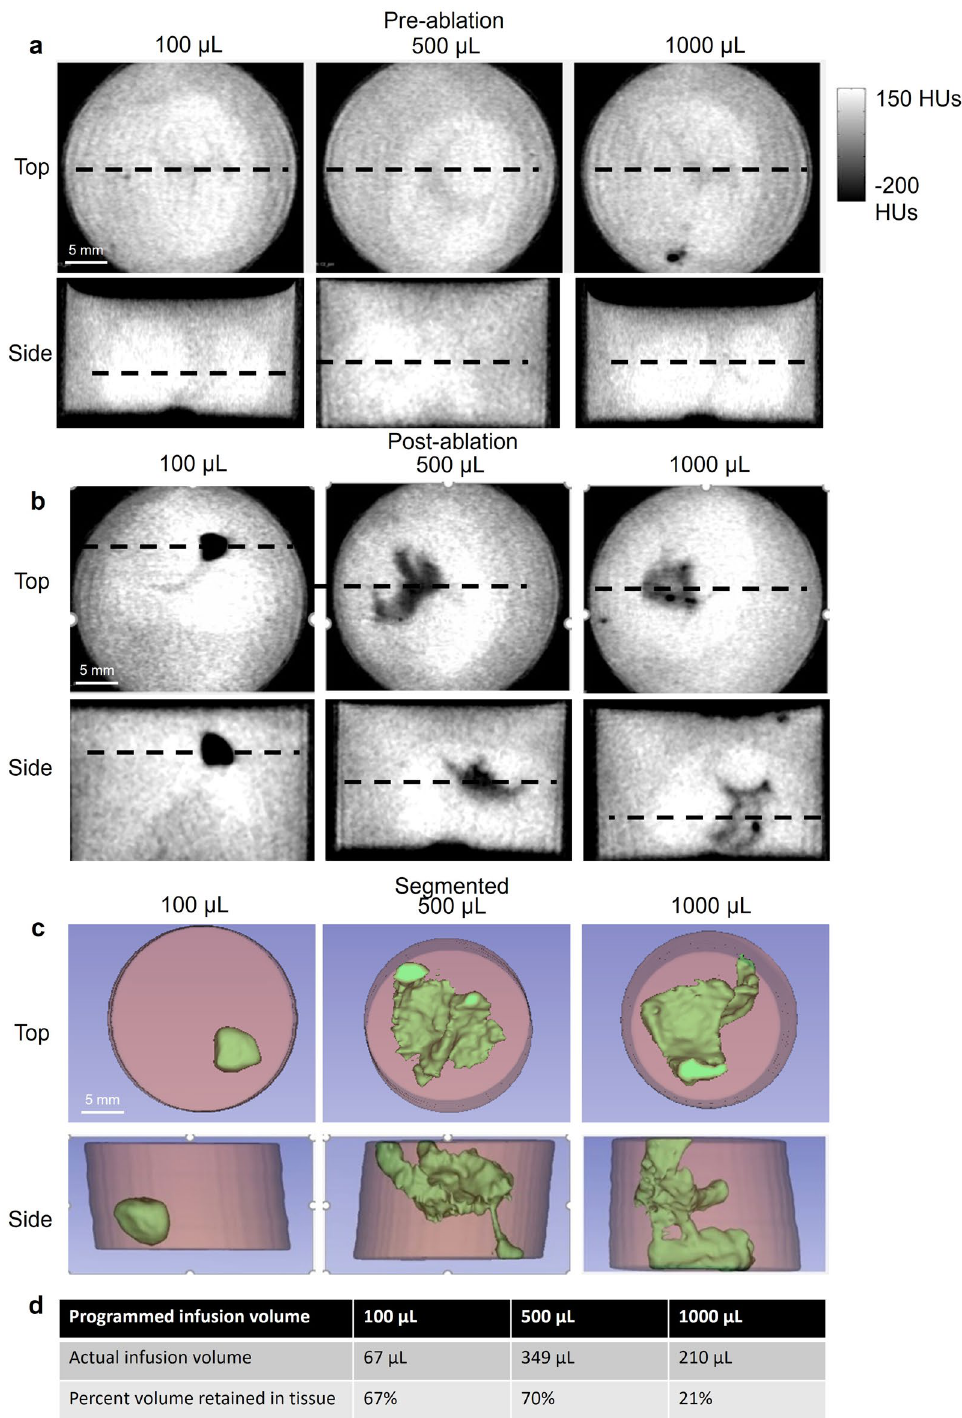
Figure 5. CT images 12% EC-ethanol in the ex vivo swine cervix (manual needle insertion, ~ 6.5 mm insertion depth, 12% EC-ethanol, 10 mL/h infusion rate, 100 µL, 500 µL, or 1000 µL infusion volumes). ( a ) Pre-ablation images obtained before the injection (baseline images shown from the top and side of the sample). Black dotted lines represent the plane of the corresponding image for each sample. ( b ) Post-ablation images were obtained approximately 5 min post injection. For each 2D image, the top and side view corresponding to the largest distribution are shown. Ethanol is less radiodense than cervix tissue and appears black in the image. ( c ) Segmentation of distribution volumes. A threshold of 0 HUs was applied to segment the ethanol region. Projections of top and sideviews of the cervix are shown where ethanol is false colored green. Scale bars are 5 mm. ( d ) Programmed infusion volumes of 100 µL, 500 µL, or 1000 µL infusion volumes led to distribution volumes of 67, 349, and 210 µL, respectively. The corresponding percentage volume retained within the tissue was 67%, 70%, and 21%, respectively, for the three infusion